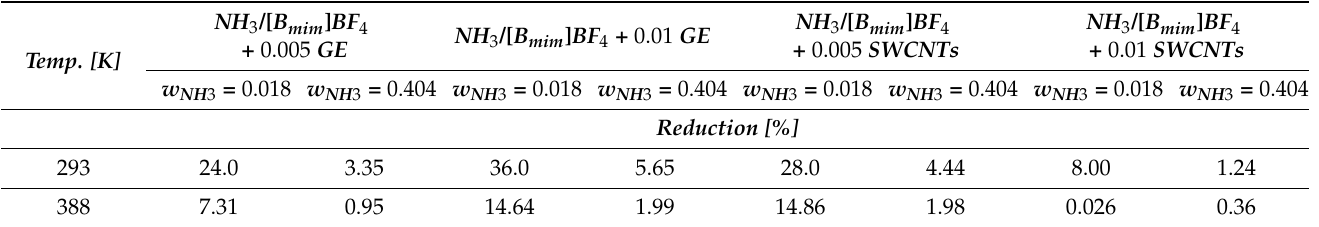
Table 4: Table 4. Reduction in dynamic